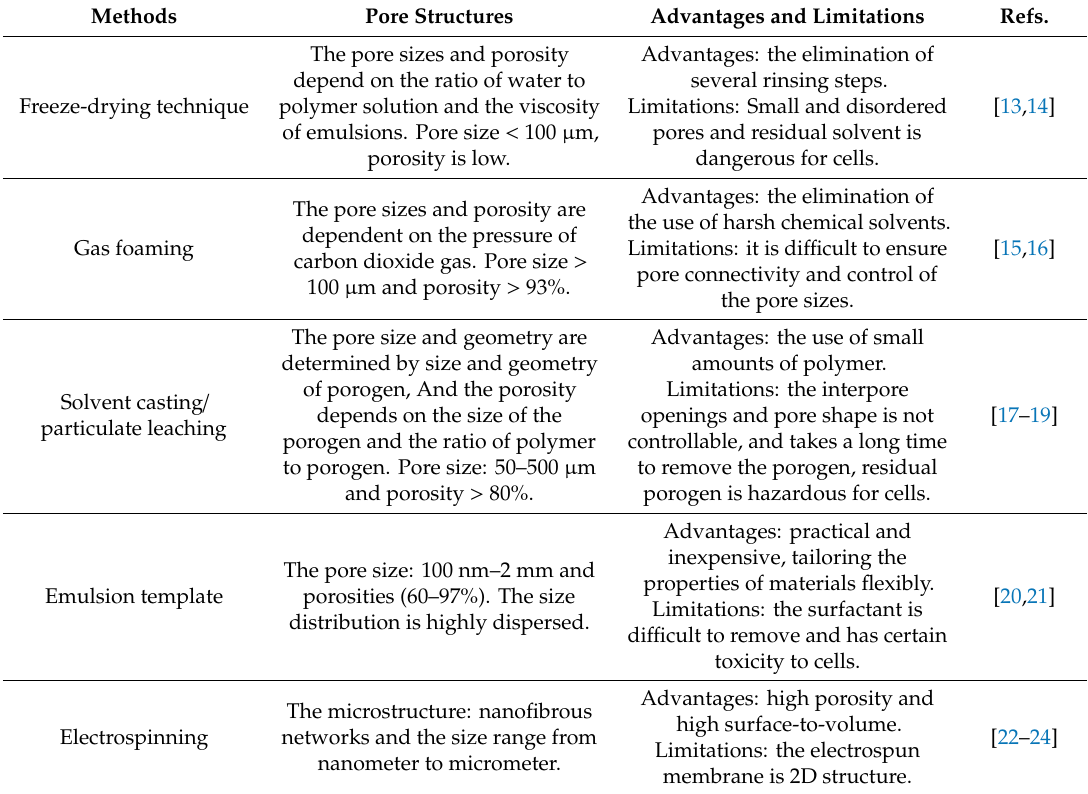
Table 1. The advantages and limitations of conventional methods for engineering sca ff